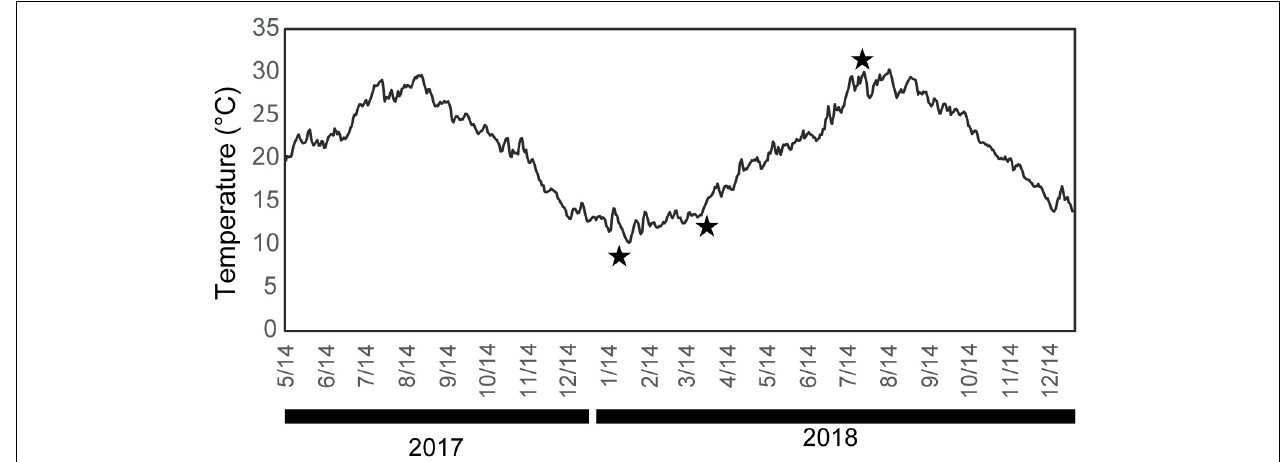
FIGURE 1 | Daily mean water temperature at the sampling point (2-m depth). Stars indicate the sampling dates (January 26, April 4, and August 2,